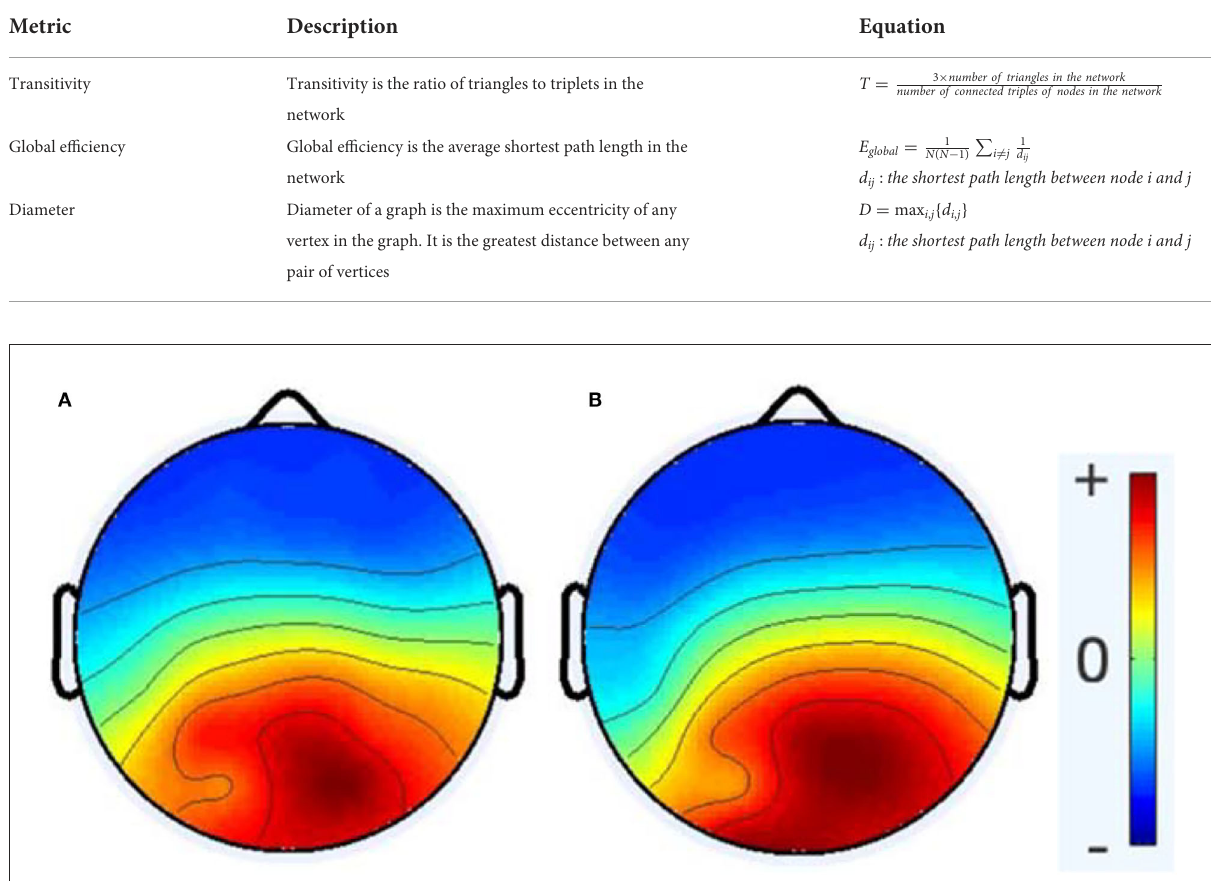
TABLE 4 Description of graph